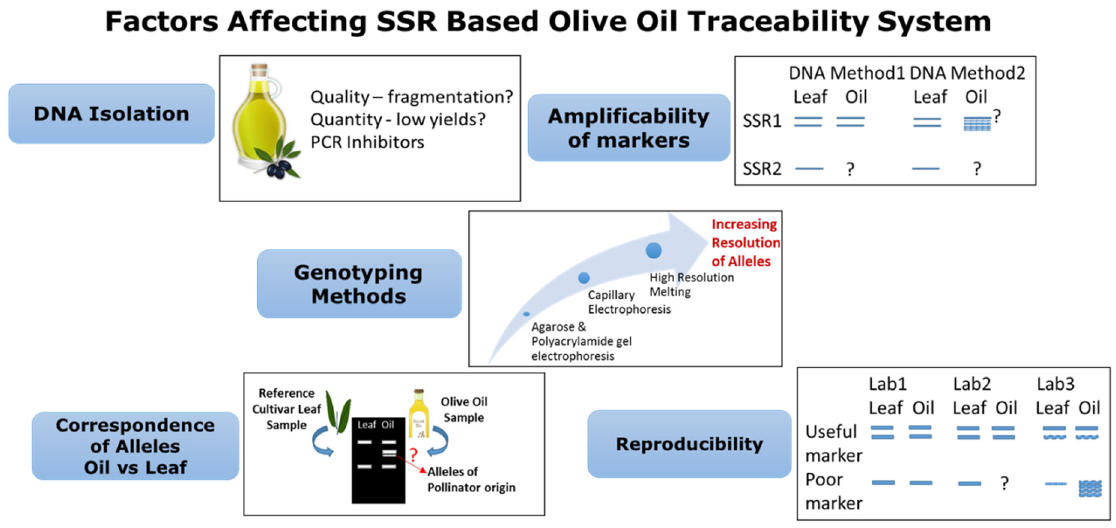
Figure 2. Process and main factors influencing the applicability of a microsatellite marker in the authentication and traceability of olive oils and table olives.